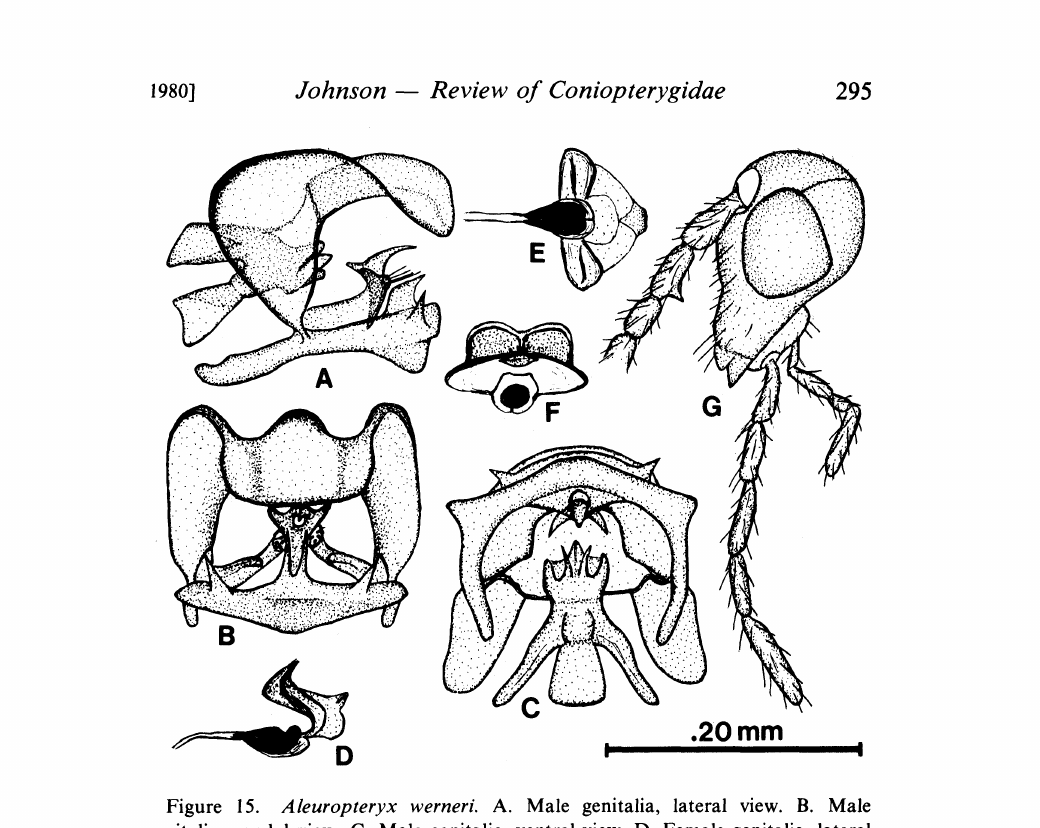
Figure 15. Aleuropteryx werneri. A. Male genitalia, lateral view. B. Male genitalia, caudal view. C. Male genitalia, ventral view. D. Female genitalia, lateral view. E. Female genitalia, ventral view. F. Female genitalia, caudal view. G. Male head, lateral